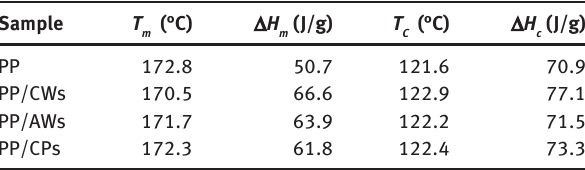
Table 3: Thermal data obtained by DSC measurements for neat PP and composites reinforced with 5 wt% CWs, AWs,